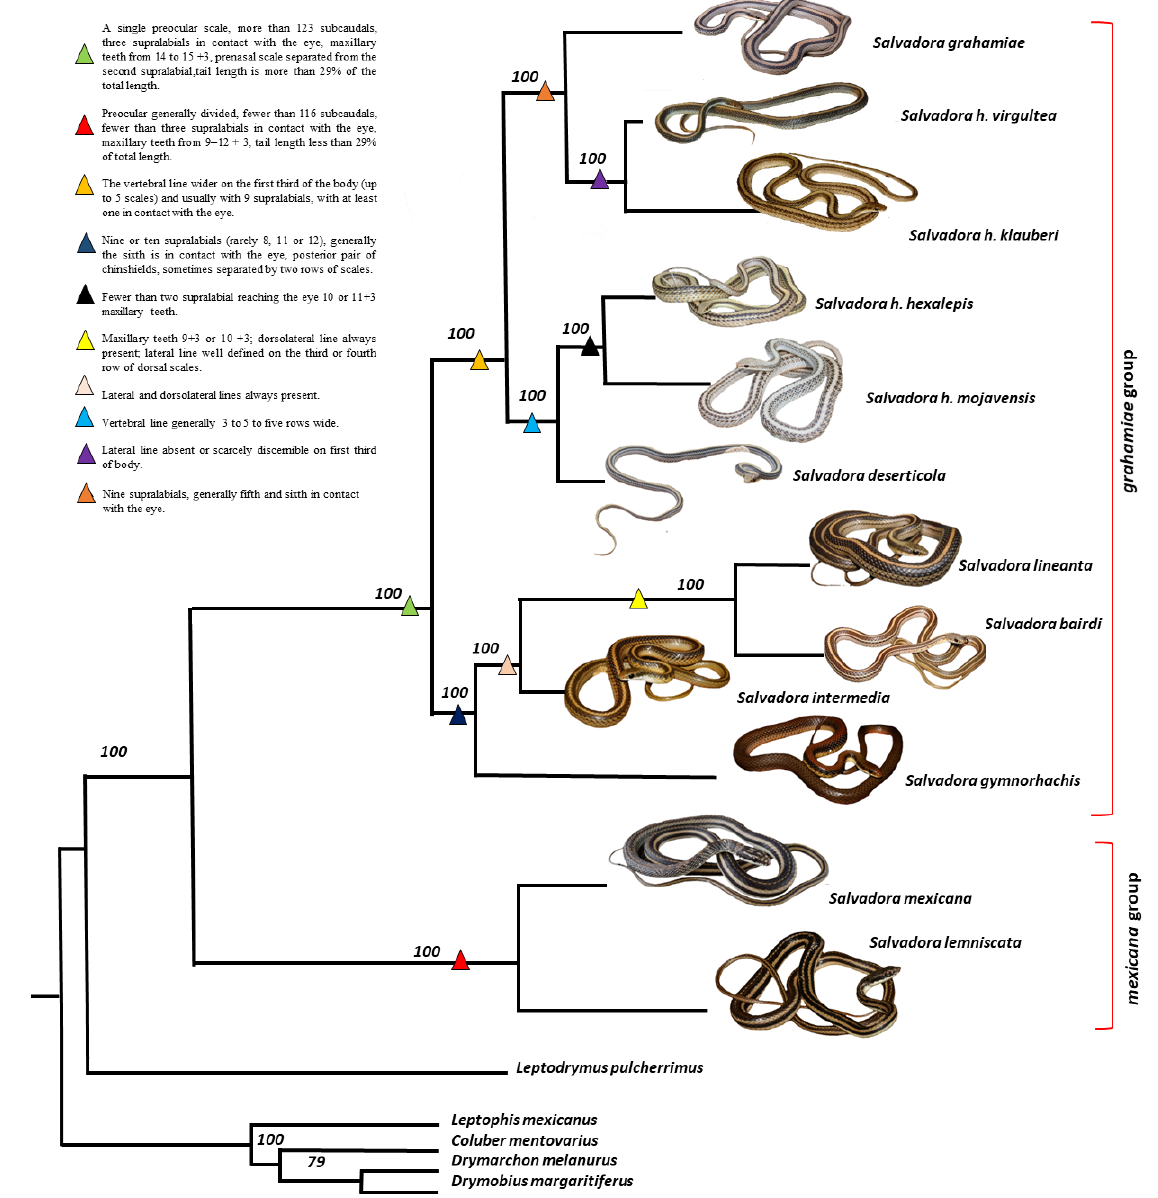
Fig. 2. Tree obtained based on a heuristic search under the parsimony criterion, with a length of 584 837 steps, a consistency index (CI) of 0.8297 and a retention index (RI) of 0.8276; numbers over the nodes represent the